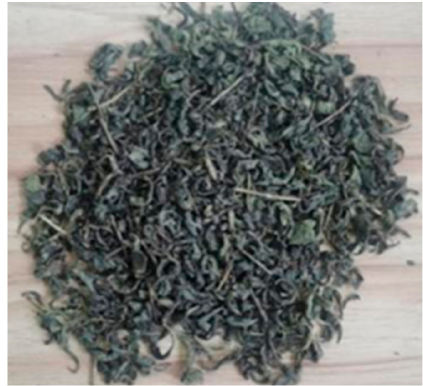
Figure 13. Pan-fried green tea.